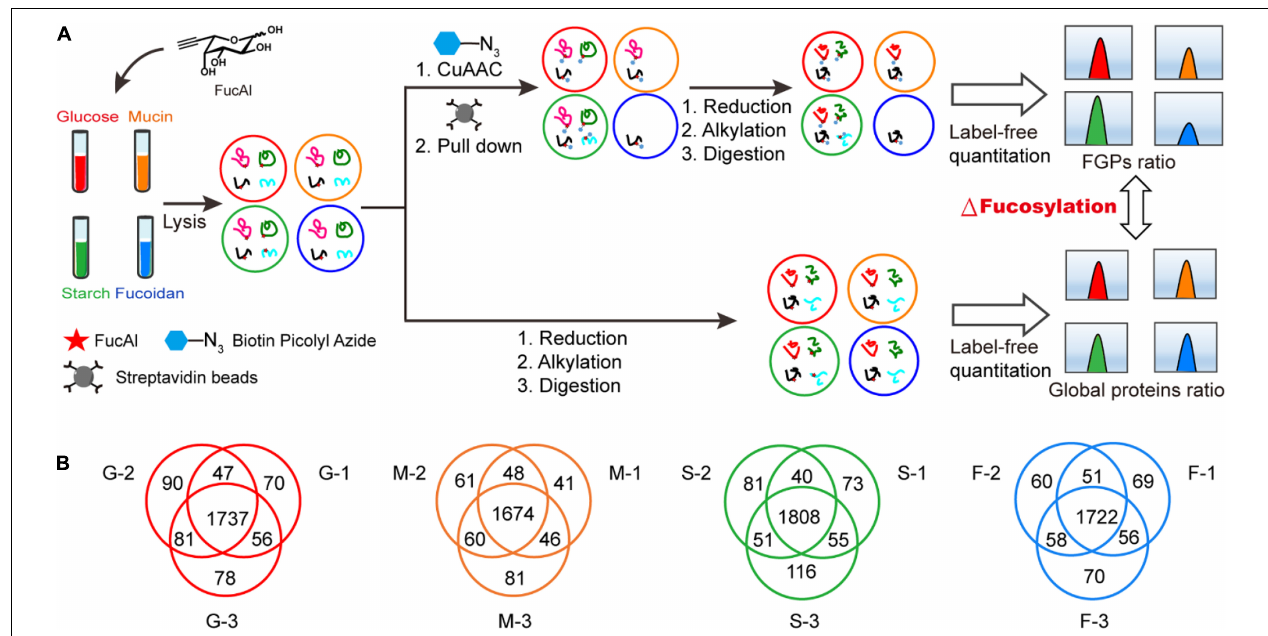
FIGURE 3 | Label-free quantitative comprehensive proteomes of FGPs. (A) Workflow for label-free quantitative comprehensive proteomes of FGPs. (B) Venn diagrams of three repeated experiments in each group.